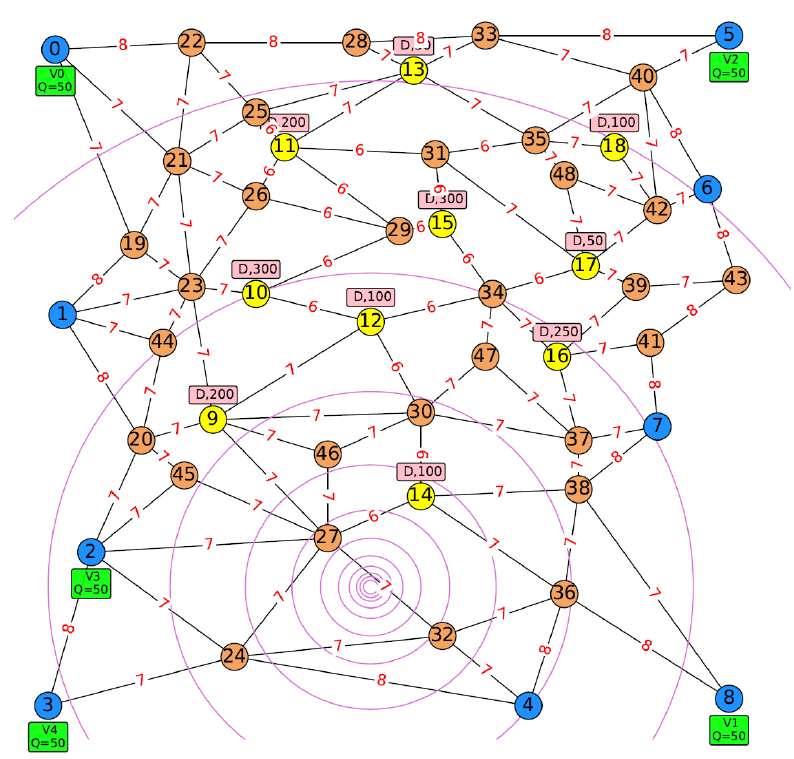
Figure A9. Road network for instance